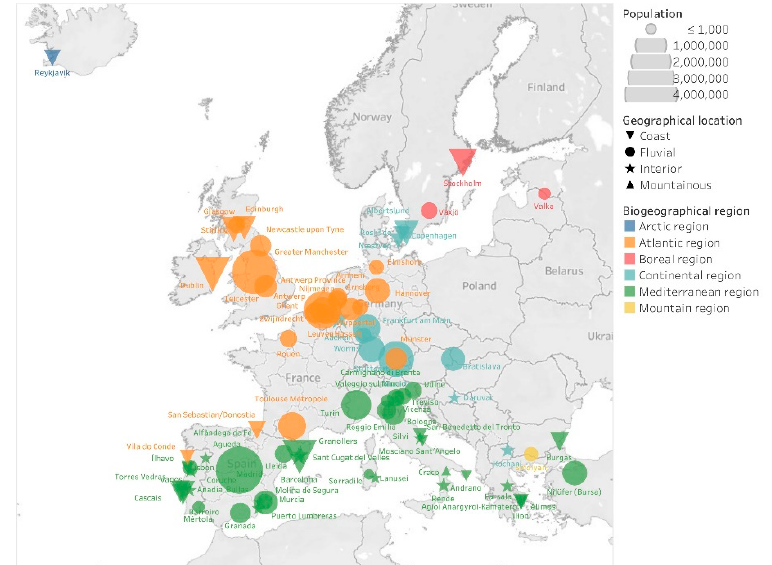
Figure 5. Distribution of the 84 good practices of the Mayors Adapt initiative. The population of the city, the geographical location and the biogeographical region to which the municipality belongs are indicated. Source: compiled by the authors from Mayors Adapt information [19].